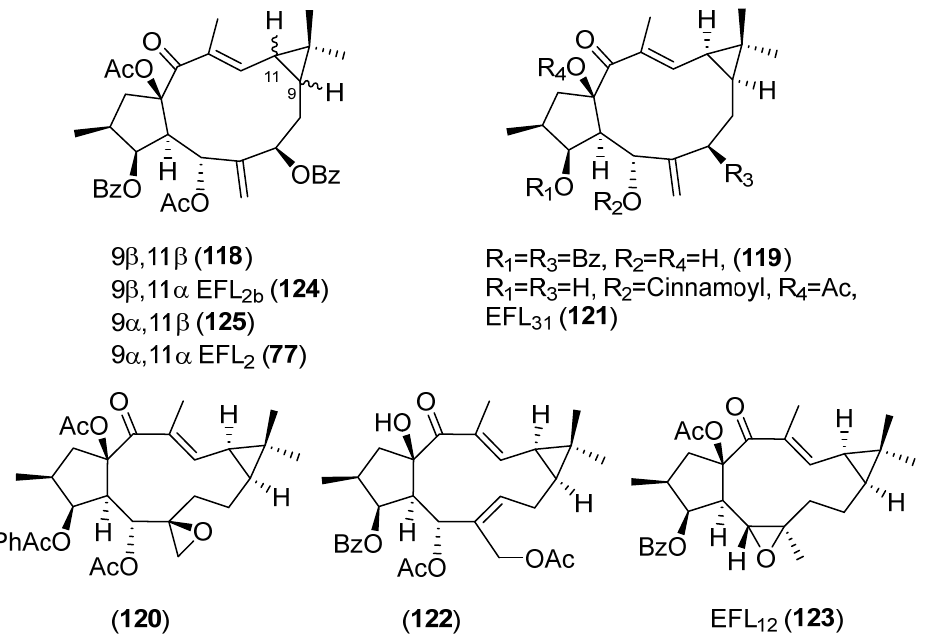
Figure 20. Structure of compounds 77 , 118 – 125 .